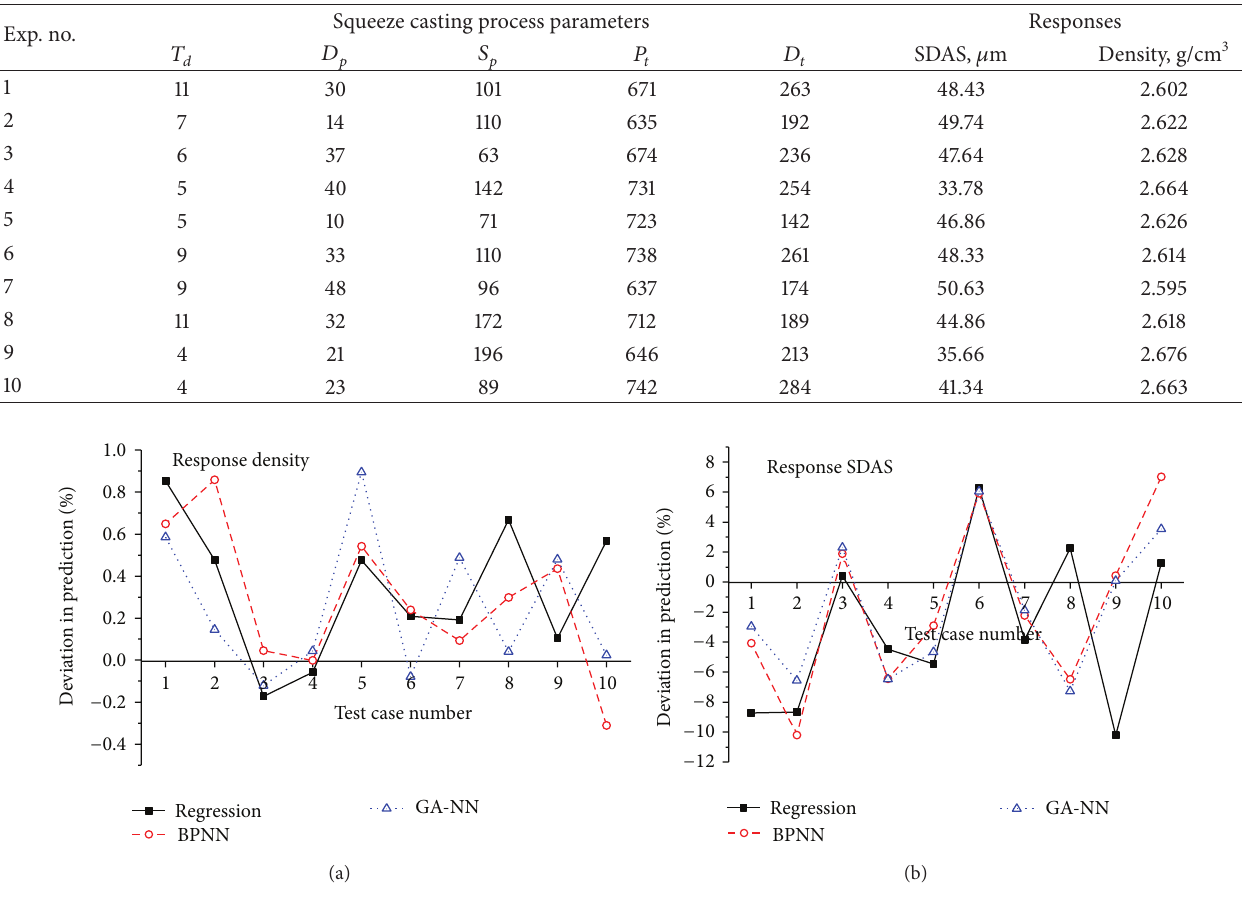
Figure 5: Comparison of three models in terms of percent deviation in predictions. (a) Density and (b) secondary dendrite arm spacing.